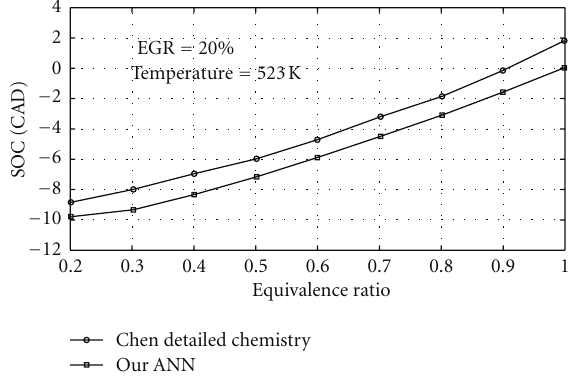
Figure 7: SOC versus temperature (all other thermodynamic conditions and engine geometry are the same).